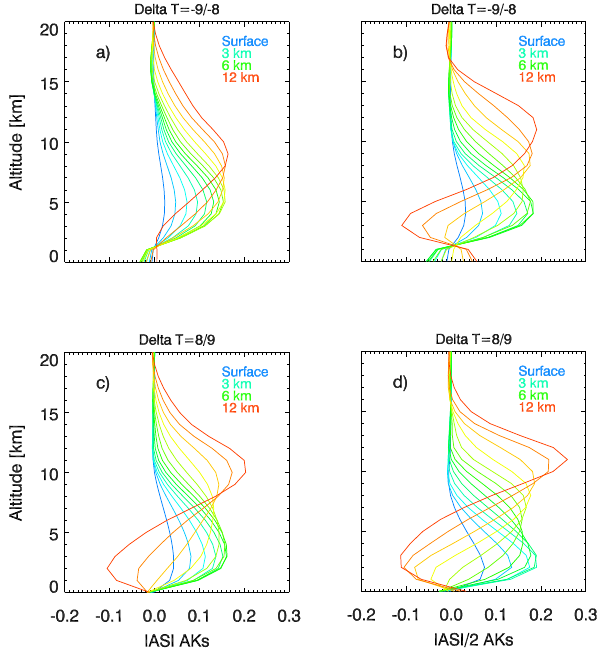
Fig. 2. Averaging kernel functions from surface (sky blue) to 12km (red) for IASI: (a) low sensitivity scenario, and (c) high sensitivity scenario, and IASI/2: (b) low sensitivity scenario, and (d) high sen- sitivity scenario. The functions are means over the whole period of study (August